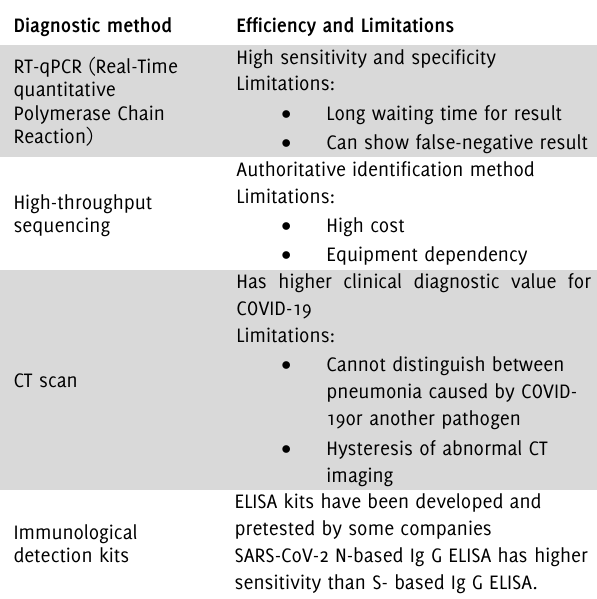
Table 1. The various diagnostic methods used for detection of COVID-19.